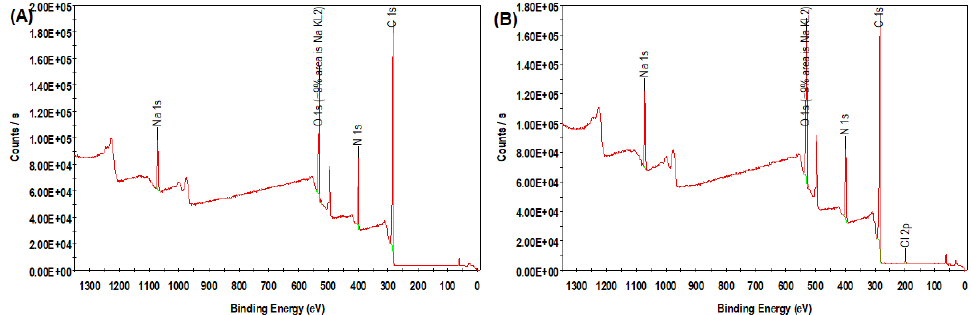
Figure 2. The XPS spectra for both the unmodified membrane ( A ) and the modified membrane ( B ).